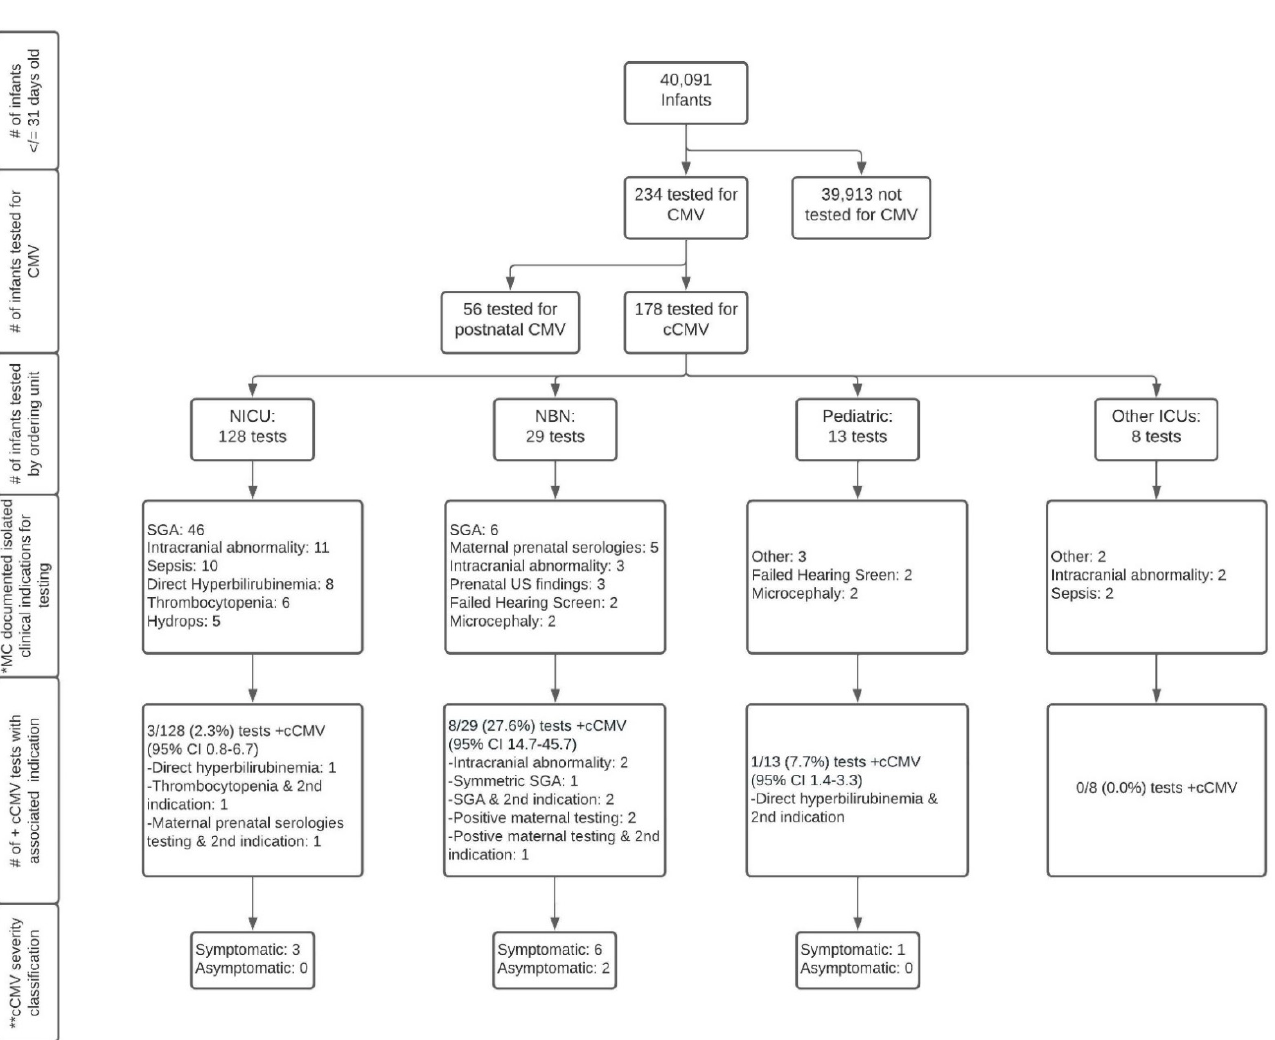
Figure 1. Flowchart of congenital cytomegalovirus testing in infants at a quaternary children’s hos- pital from 2014 to 2019. Abbreviations: CMV—cytomegalovirus; cCMV—congenital cytomegalovi- tal from 2014 to 2019. Abbreviations: CMV—cytomegalovirus; cCMV—congenital rus; NICU—neonatal intensive care unit; NBN—newborn nursery; Other ICUs—intensive care